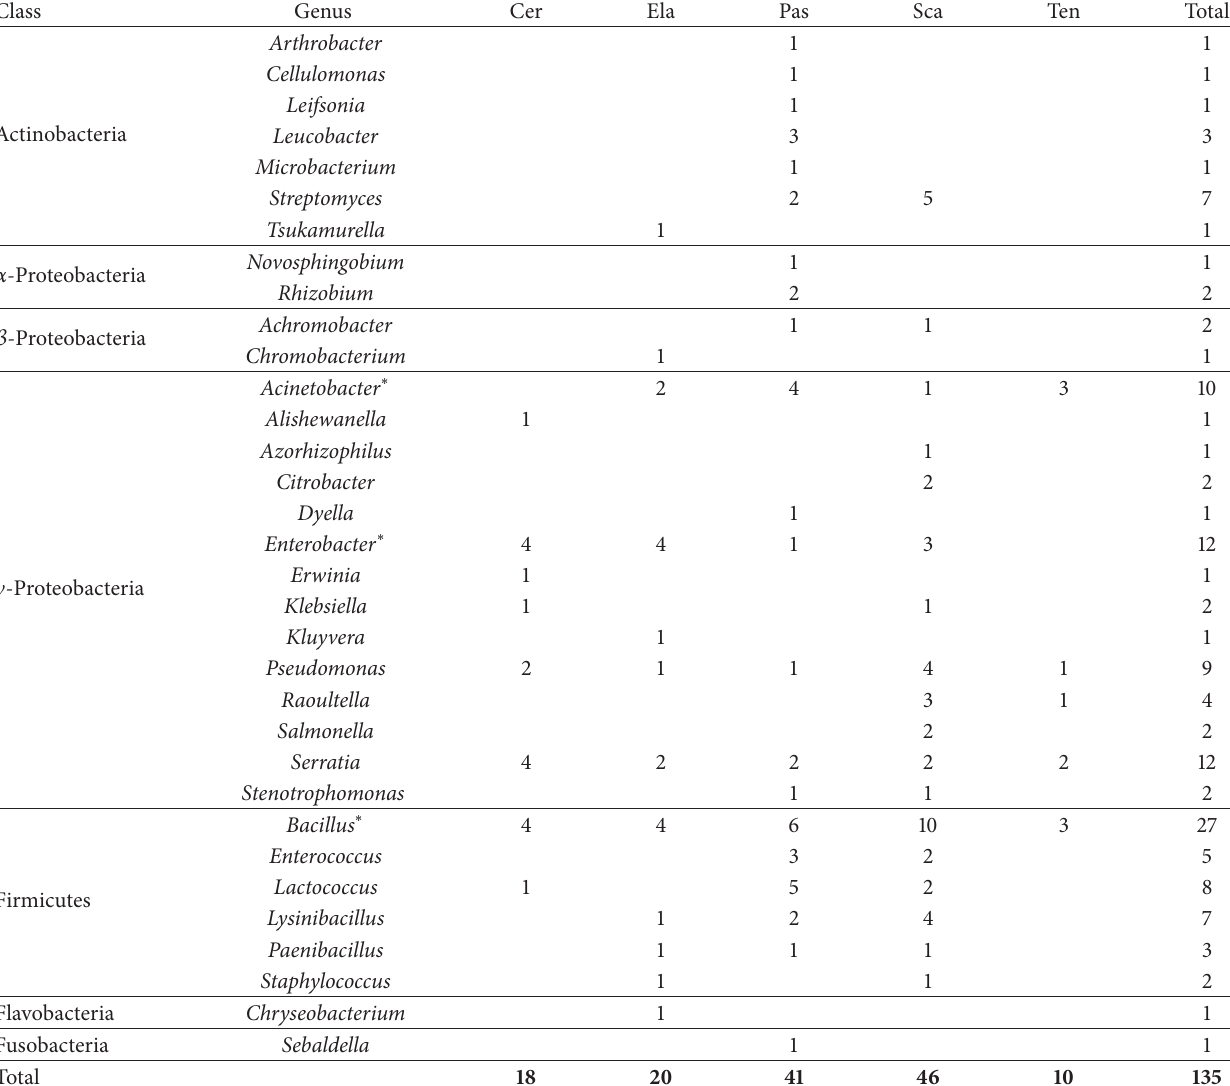
Table 4: Taxonomic distribution of the bacterial isolates obtained in this study. The number of isolates at the phylum and genera level is shown for each of the coleopteran